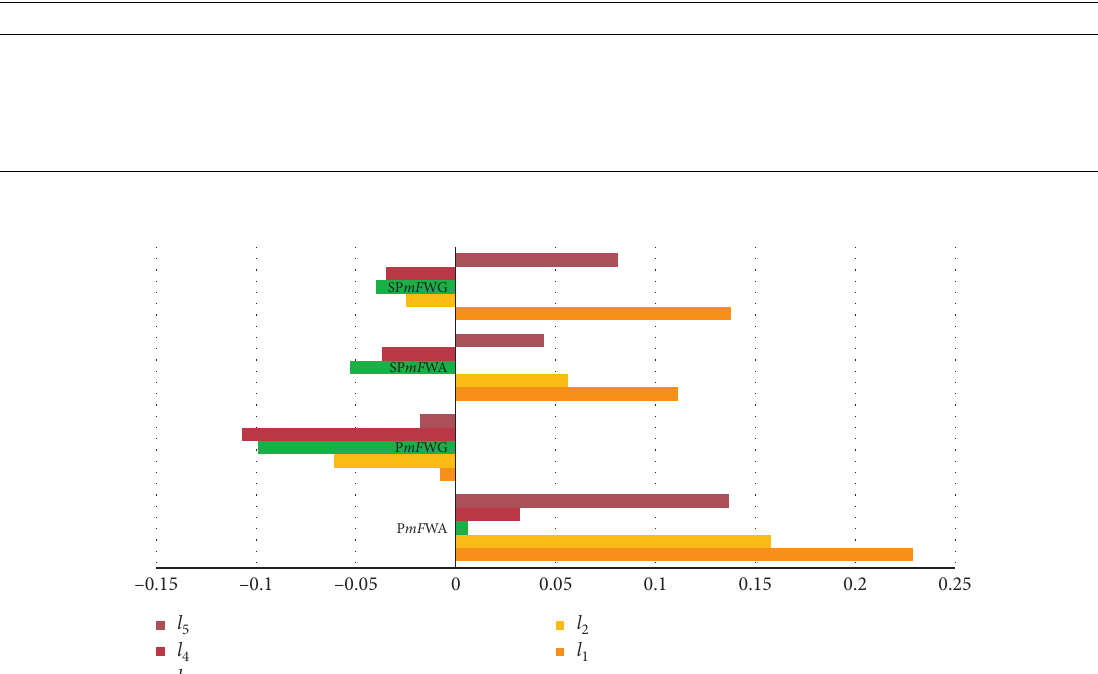
Table 10: Values of score function against each choice.